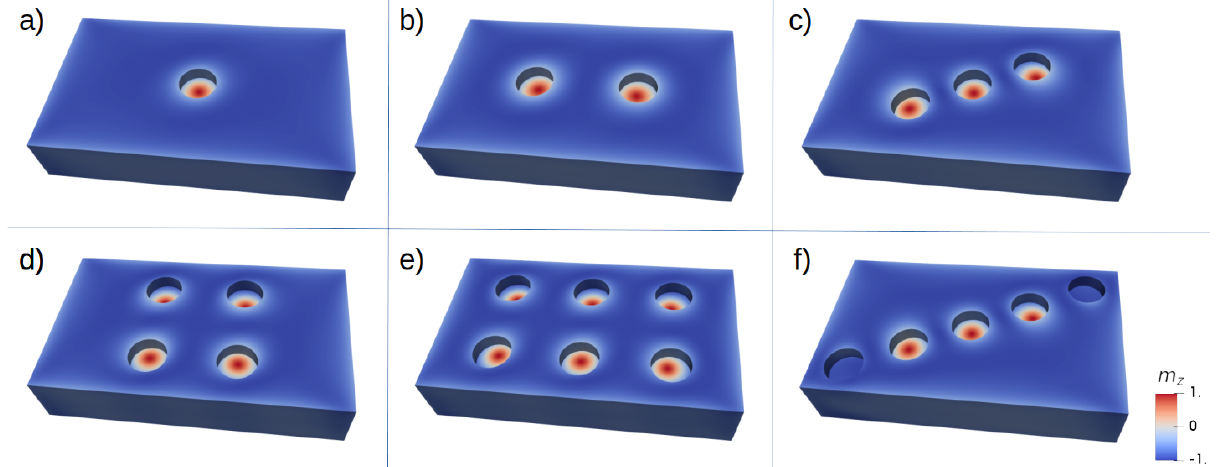
Figure 5. Geometrically constrained skyrmions in FeGe platelets. By introducing circular pockets at specific positions, skyrmions can be artificially stabilized at positions that they would otherwise not attain. Panels ( a – e ) show examples in which each pocket contains a skyrmion. The geometric control, however, is not unlimited. Attempts to pack skyrmions too closely or to place them too close to the sample boundary can fail. This is shown in panel ( f ), where skyrmions are stabilized only in the three central pockets, while the two outermost pockets remain